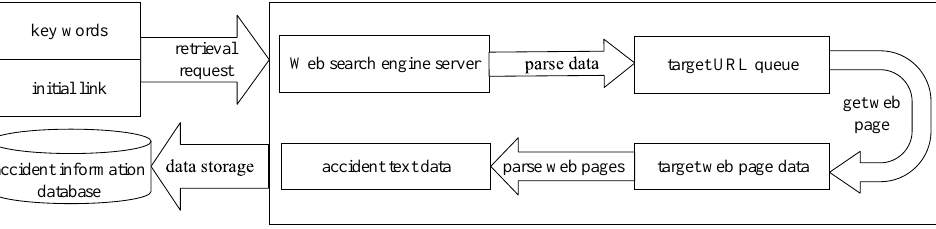
Figure 9. Process of getting power grid accident data by web crawler.